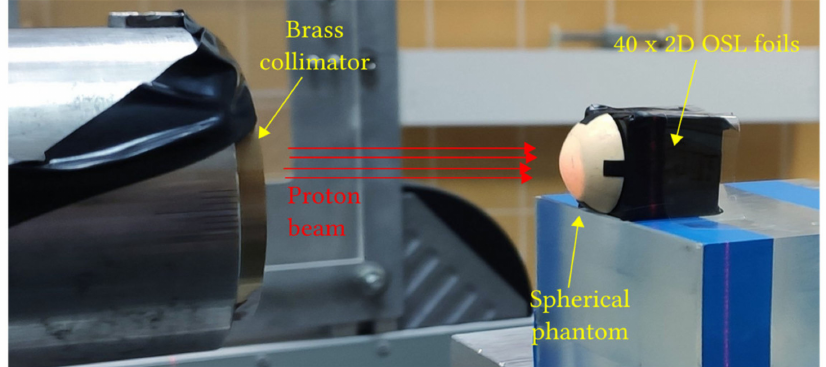
Figure 6. Experimental setup: 40 silicone 2D LMP foils attached to 10 PMMA holders behind a spherical phantom, mounted on the top of the therapeutic chair in the treatment room, irradiated with 58.8 MeV modulated and collimated proton